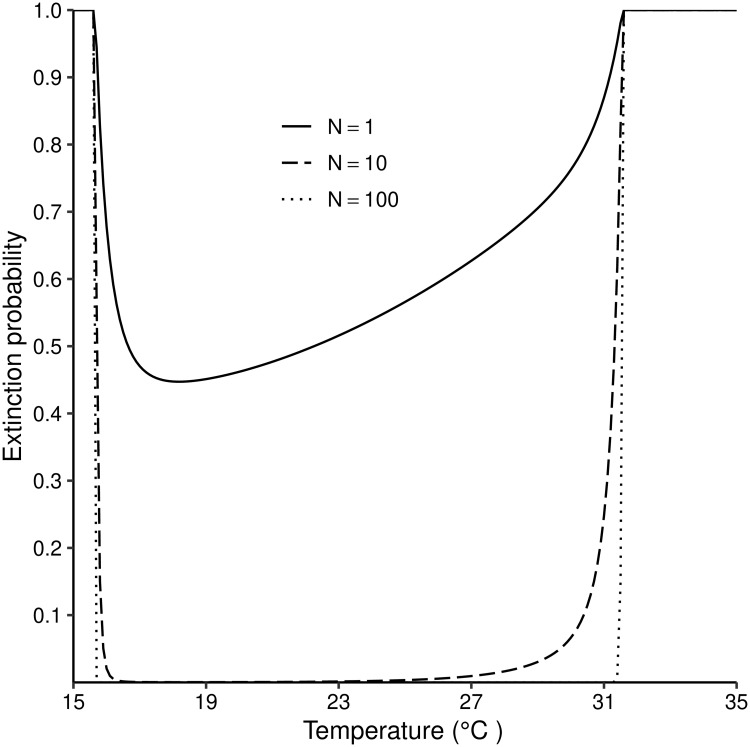
Probability of extinction of a population of G. m. morsitans as a function of temperature varying between 15°C and 35°C.Eq (7) solved for different values of temperature and for different numbers of inseminated adult females in the initial population.